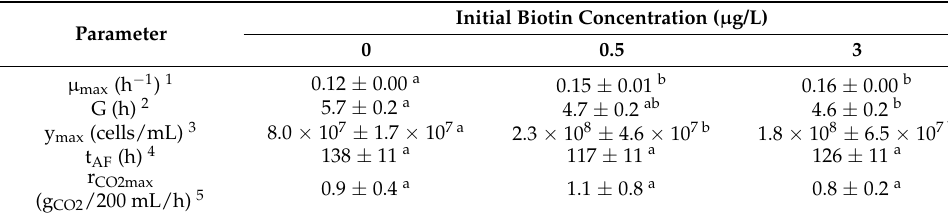
Table 2. Initial biotin impact on the growth and fermentation